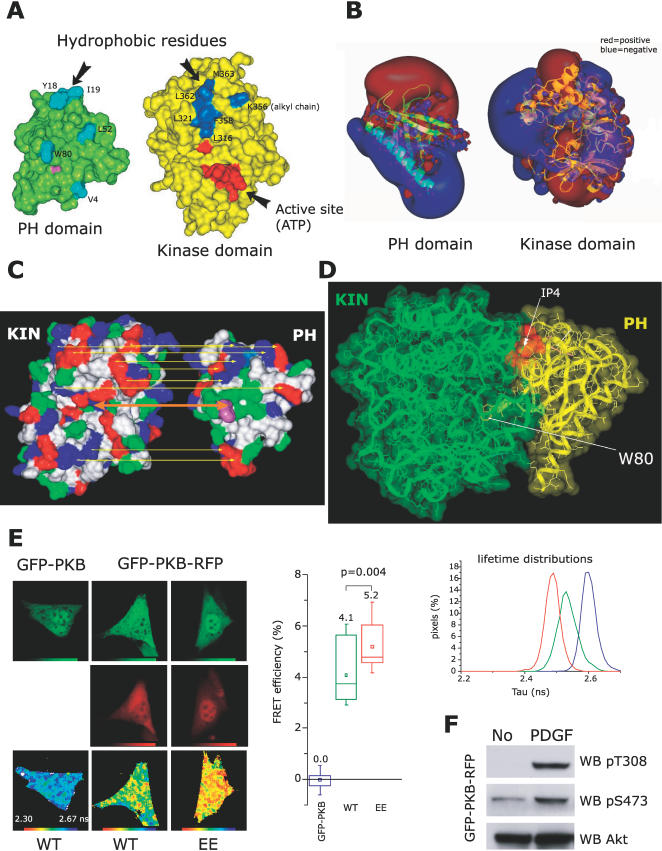
PKB PH and Catalytic Domains Interact in the PKB Inactive State(A) The solvent-accessible surface of the domains are shown in green (PH) and in yellow (kinase) and the hydrophobic patches are indicated. The IP4 binding site is in magenta (located to the rear of PH domain) and the ATP active site is in red.(B) The electrostatic potential maps of PKB PH and kinase domains are calculated in the complexed form, based on crystal structures of PKBα PH domain. A strong complementarity between the positive and negative lobes of the PH and kinase domains is seen.(C) Acidic (red), basic (blue), and polar (green) residues are presented here. The Trp80 is shown in purple and Arg25 is shown in light blue. The yellow arrows show the complementarity between the acidic and basic residues in each domain. The orange arrow shows the docking site of Trp80 in the kinase domain cleft.(D) The model of complexed PKBα PH domain (yellow) and the rebuilt catalytic domain model (green) is based on the hydrophobicity in an aqueous environment. To visualise the binding site of the lipid head group in the complex, IP4 is represented as CPK (Corey-Pauling-Koltun) orange spheres. Note that IP4 cannot be positioned unless the PH and kinase domains are separated.(E) NIH3T3 cells were transfected either with GFP-PKB or GFP-PKB-RFP (WT) or mutant (EE). The lifetimes are in pseudo-colour scale ranging from 2.30 to 2.67 ns. The graph shows the lifetime distributions: GFP-PKB (blue), GFP-PKB-RFP WT (green), and EE (red). The statistical analysis shows the highly significant variation of FRET efficiency between WT and EE (p = 0.004).(F) Expression of GFP-PKB-RFP and phosphorylation on Thr308 and Ser473 sites is determined by Western blot using total protein (WB Akt) or phosphospecific antibodies as indicated.